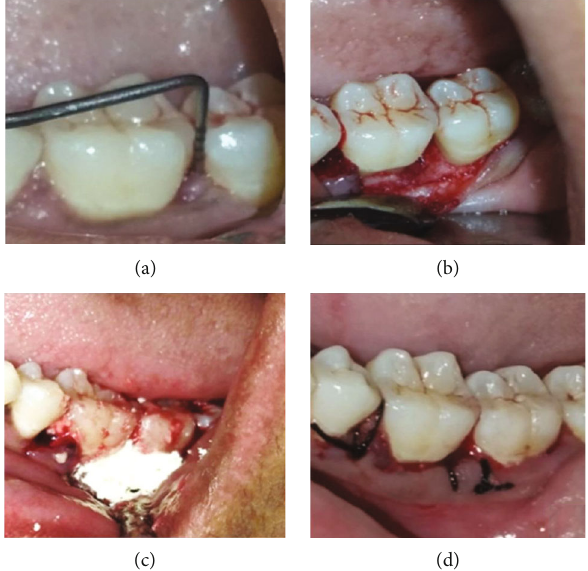
Figure 4: (a) PPD-10 mm. (b) Debridement done. (c) Placement of bovine colostrum. (d) Suturing done.